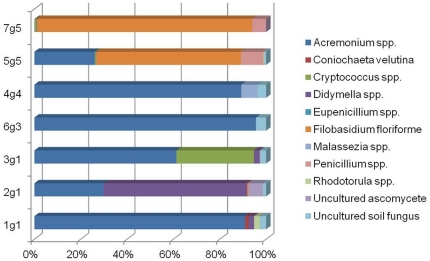
Diagram of the fungal communities at the generic level.Generic frequencies of mycobiomes in individual samples.